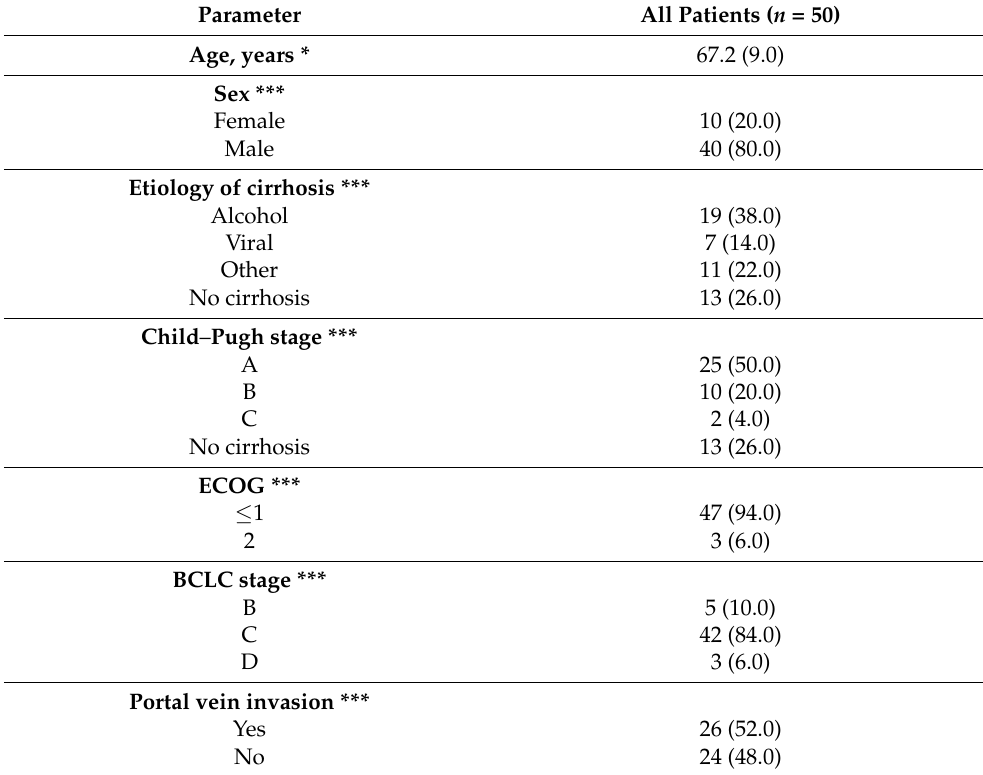
Table 1. Baseline